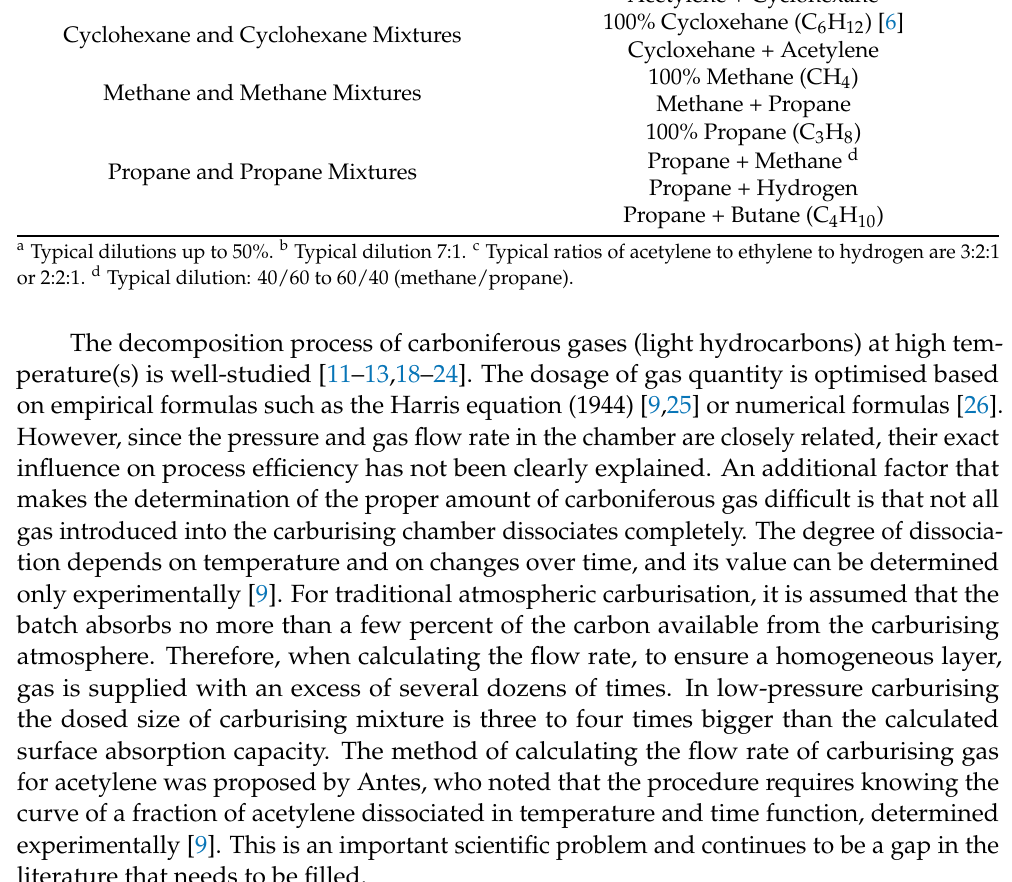
Acetylene and Aceylene